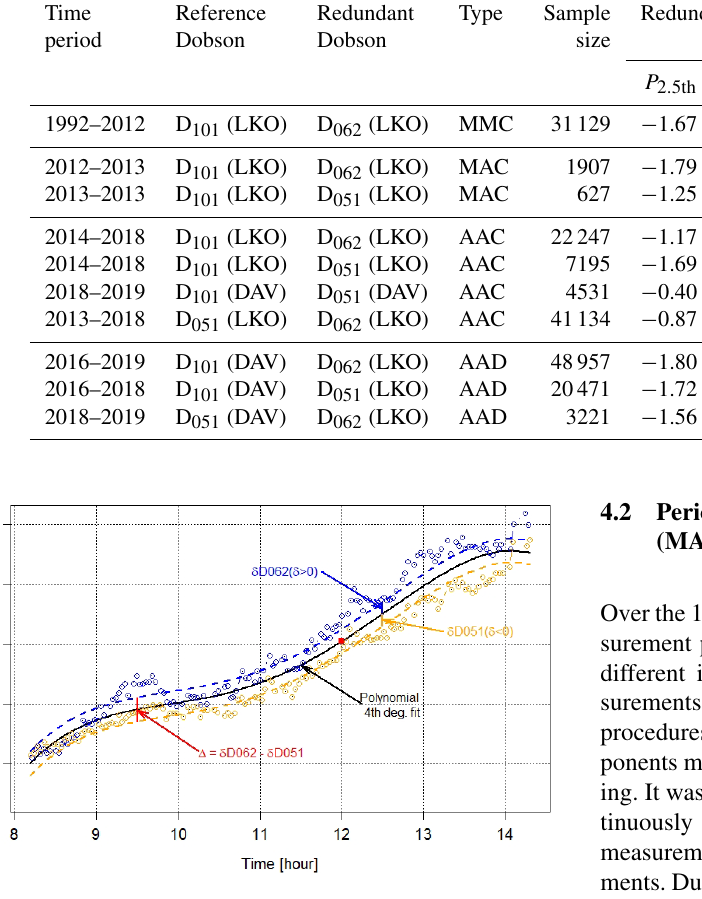
Figure 4. Illustration of the daily values of coincident D 062 and D 051 automated Dobson measurements for 27 March 2016. The black line is the polynomial fit, and the dashed lines correspond to the bias δ 062 of D 062 data (blue) and the bias δ 051 of D 051 data (orange). The difference, (cid:49) 062–051 (red), is the bias between D 062 and D 051 instruments evaluated from the coincident measurements of that